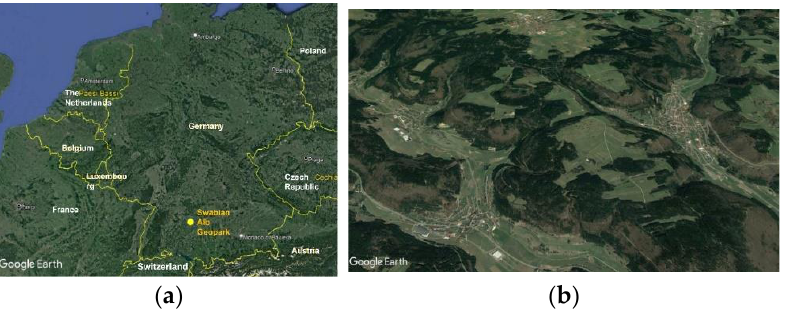
Figure 18. ( a ) The Swabian Alb park in the German territory (from Google Earth Pro V 7.3.4, (14 December 2015), 48°18′01.20″N, 9°21′16.68″E, Eye alt 1560.11 km, Landsat Copernicus, SIO, NGA, NOAA, US Navy, GEBCO, Terrametrics 2022, GeoBasis-DE/BKG 2009, [46], modified), https: //earth.google.com, modified (accessed on 2 September 2022)); ( b ) the small villages on the fringes and in the Swabian Alb Geopark (from Google Earth Pro V 7.3.4, (24 April 2021), 48 ◦ 06 (cid:48) 56.54 (cid:48)(cid:48) N, 8 ◦ 51 (cid:48) 33.77 (cid:48)(cid:48) E, Eye alt 5.97 km, Landsat, Copernicus 2022,